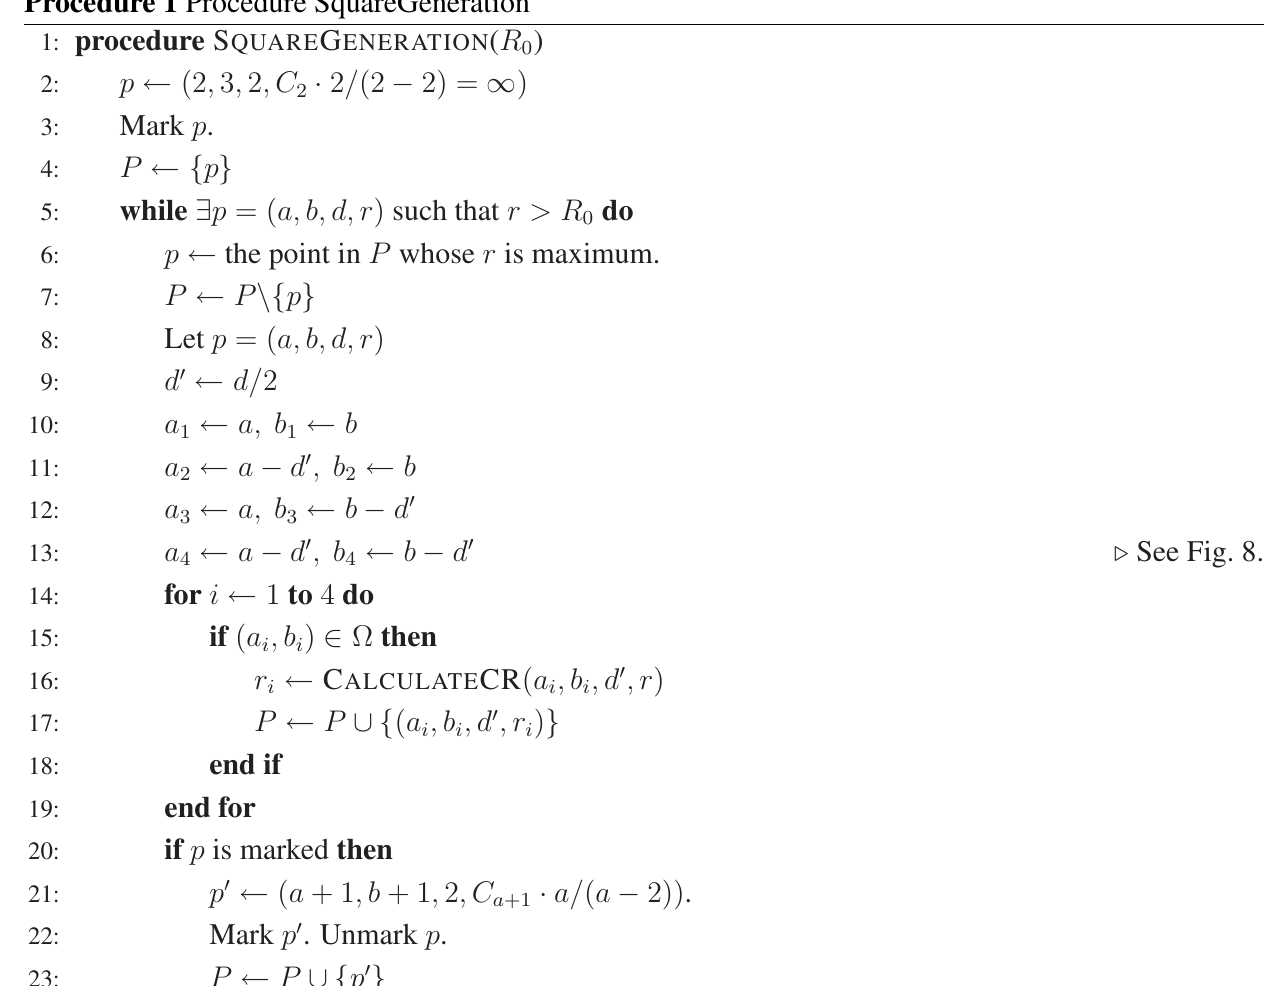
Procedure 1 Procedure